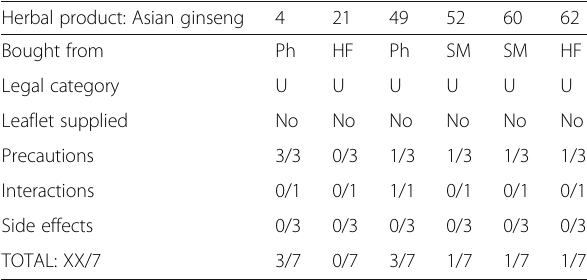
Table 4 Asian ginseng Herbal product: Asian ginseng Bought